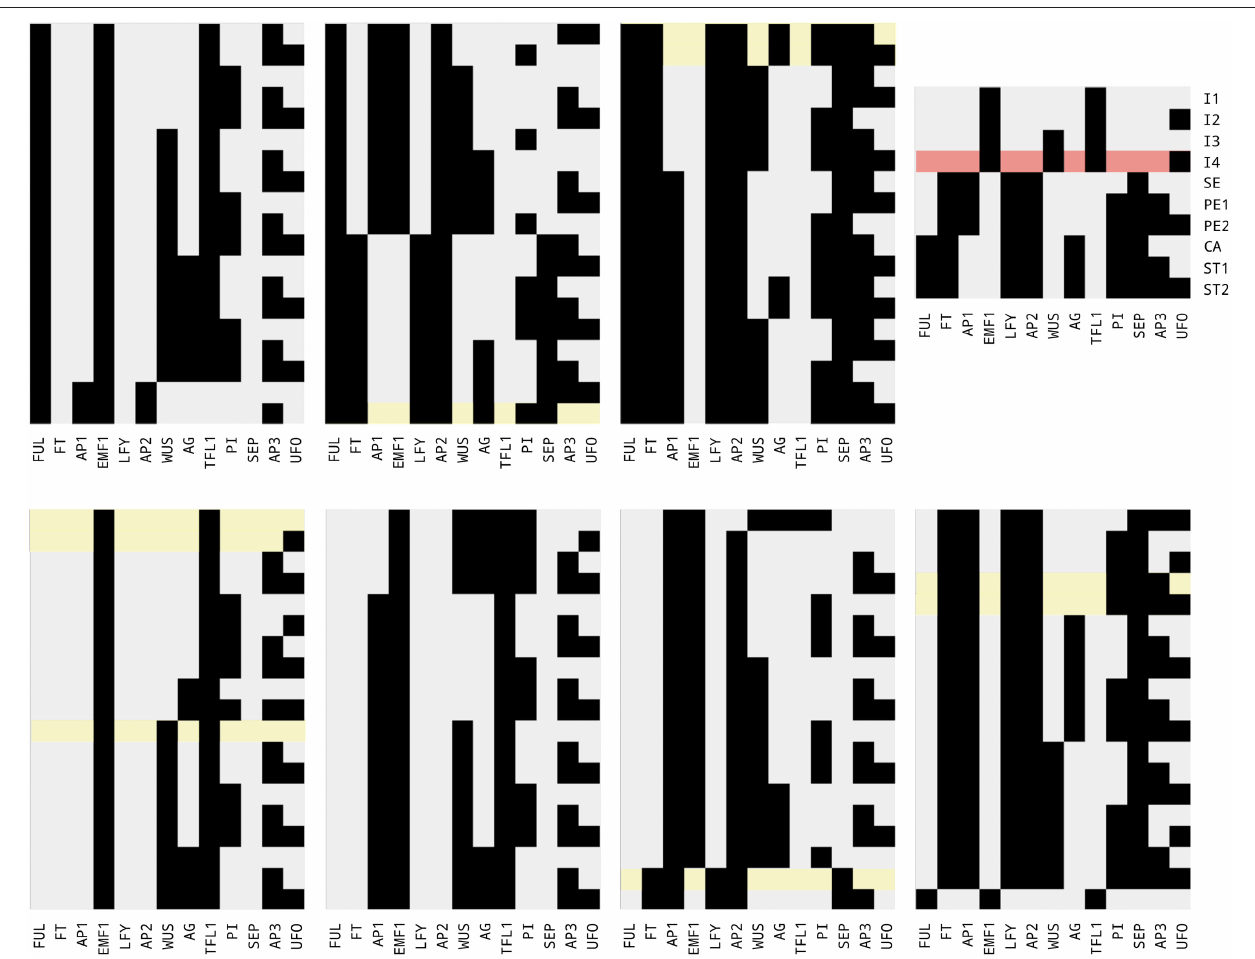
FIGURE 4 | A sample of 133 fixed-point attractors that are compatible with the interaction graph of Figure 3A . Black squares represent expressed genes; gray squares represent unexpressed genes. From bottom-left to top-right, there are seven groups of 19 rows and 13 columns each. Each column is labeled with a particular gene. Each row is an expression profile for the 13 genes and corresponds to a compatible fixed-point attractor for the regulations present in the interaction graph. At the top-right corner the 10 known fixed-point attractors corresponding to the cell types: inflorescence shoot apical meristem I1 , I2 , I3 , I4 ; sepal SE ; petal PE1 , PE2 ; stamen ST1 , ST2 ; and carpel CA . Nine of the 10 fixed-point attractors present in the sample have been highlighted in green. The algorithm used to generate the sample did not find the I4 profile highlighted in